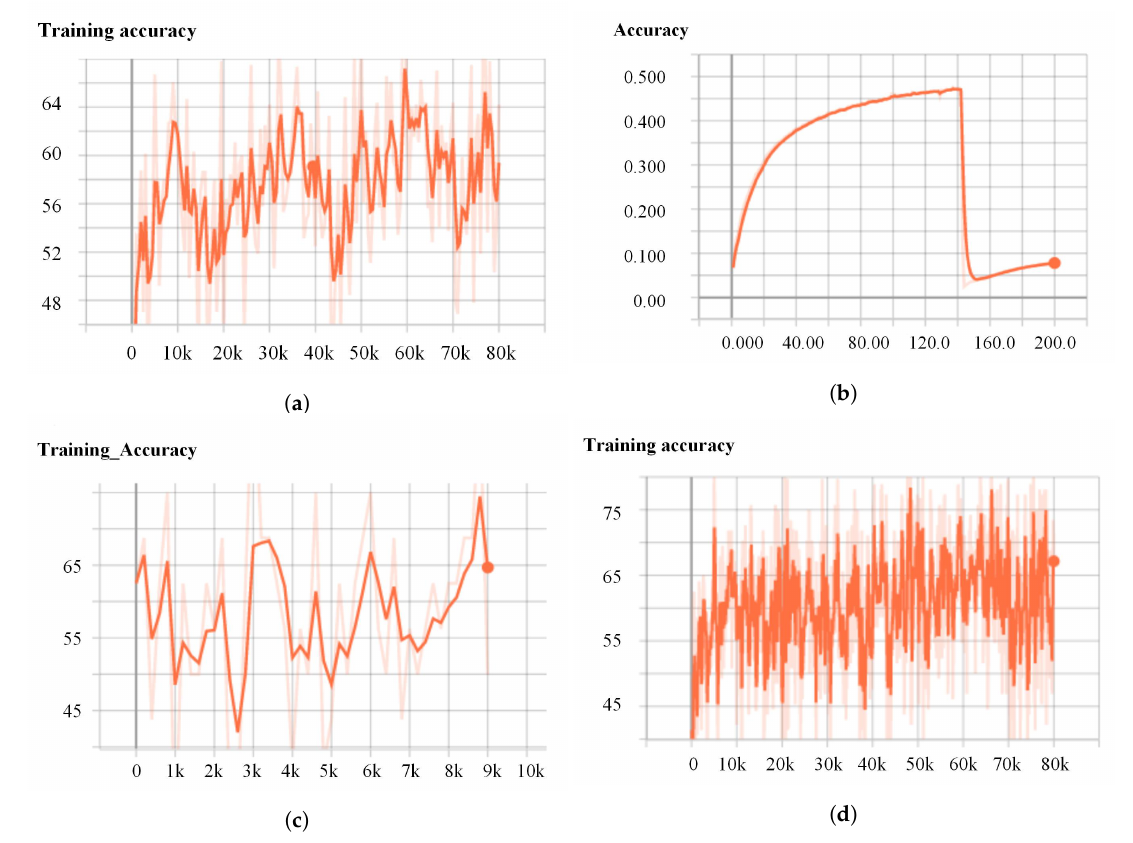
Figure 5. Comparison of training accuracy on BundleFusion . ( a ) 3DSmoothNet , ( b ) D3Feat , ( c ) SpinNet , and ( d ) KdO-Net .